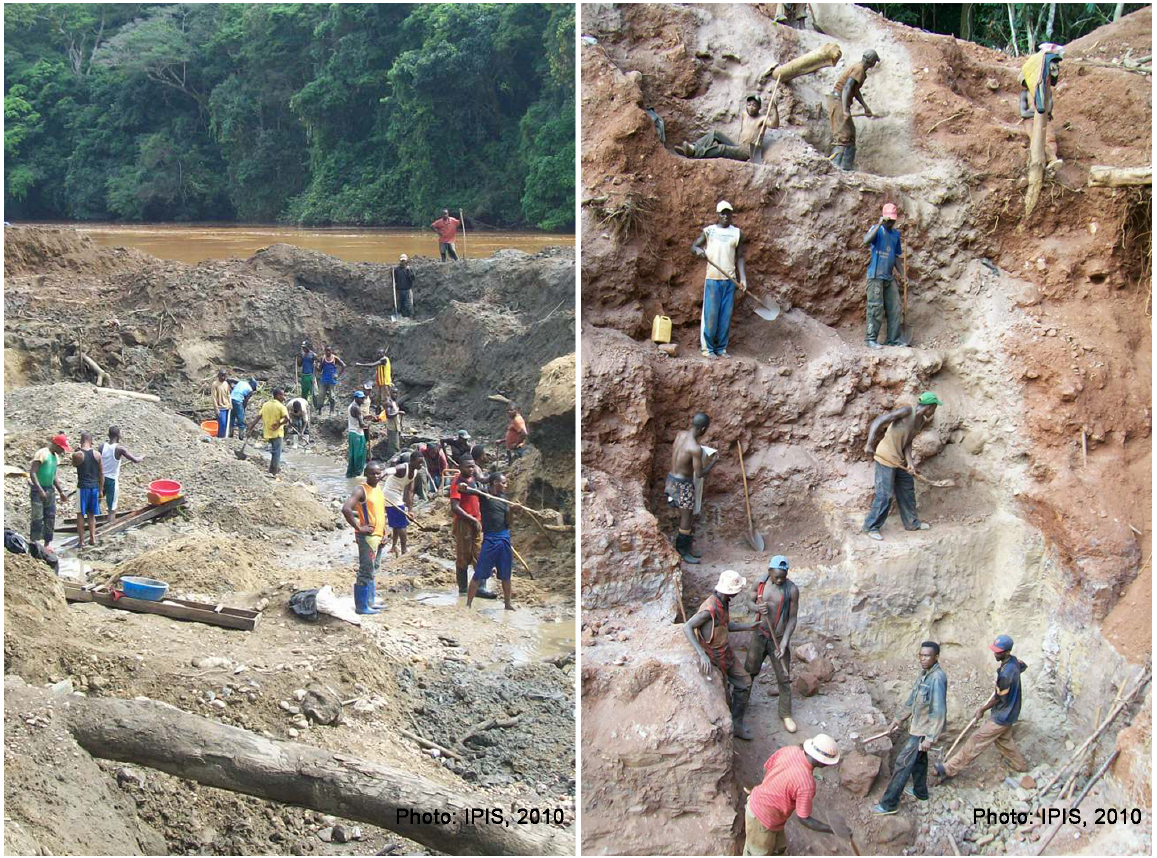
Figure 1. Examples for artisanal and small-scale open pit mining in eastern